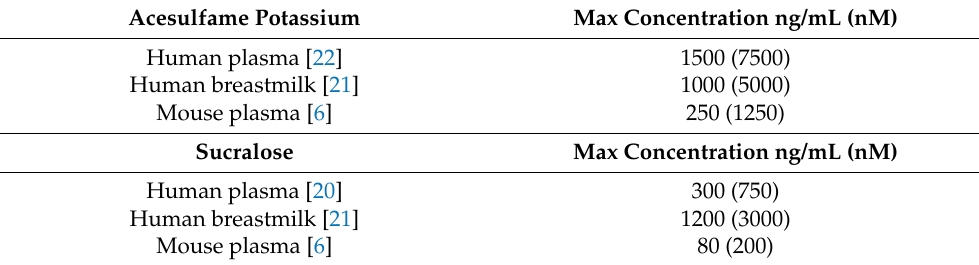
Table 1. Acesulfame potassium (AceK) and sucralose (Sucr) concentrations revealed in tissues following dietary exposure. AceK and Sucr are absorbed into the bloodstream following dietary exposure and circulate intact as they bathe tissues in the body [1]. References giving concentra- tions for each sweetener in different tissues were selected and are shown here with their highest recorded